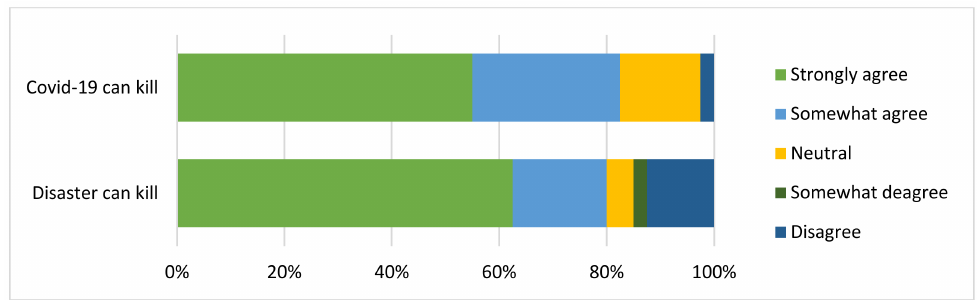
Figure 3. Perception of disaster/hazard